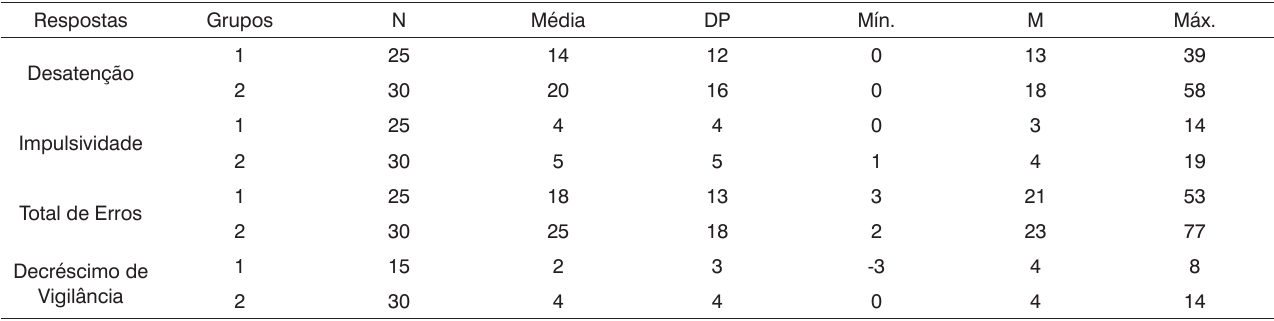
Tabela 2. Valores de média, desvio-padrão (DP), mínimo (Mín.), mediana (M) e máximo (Máx.) para as respostas do teste THAAS, para ambos os grupos.